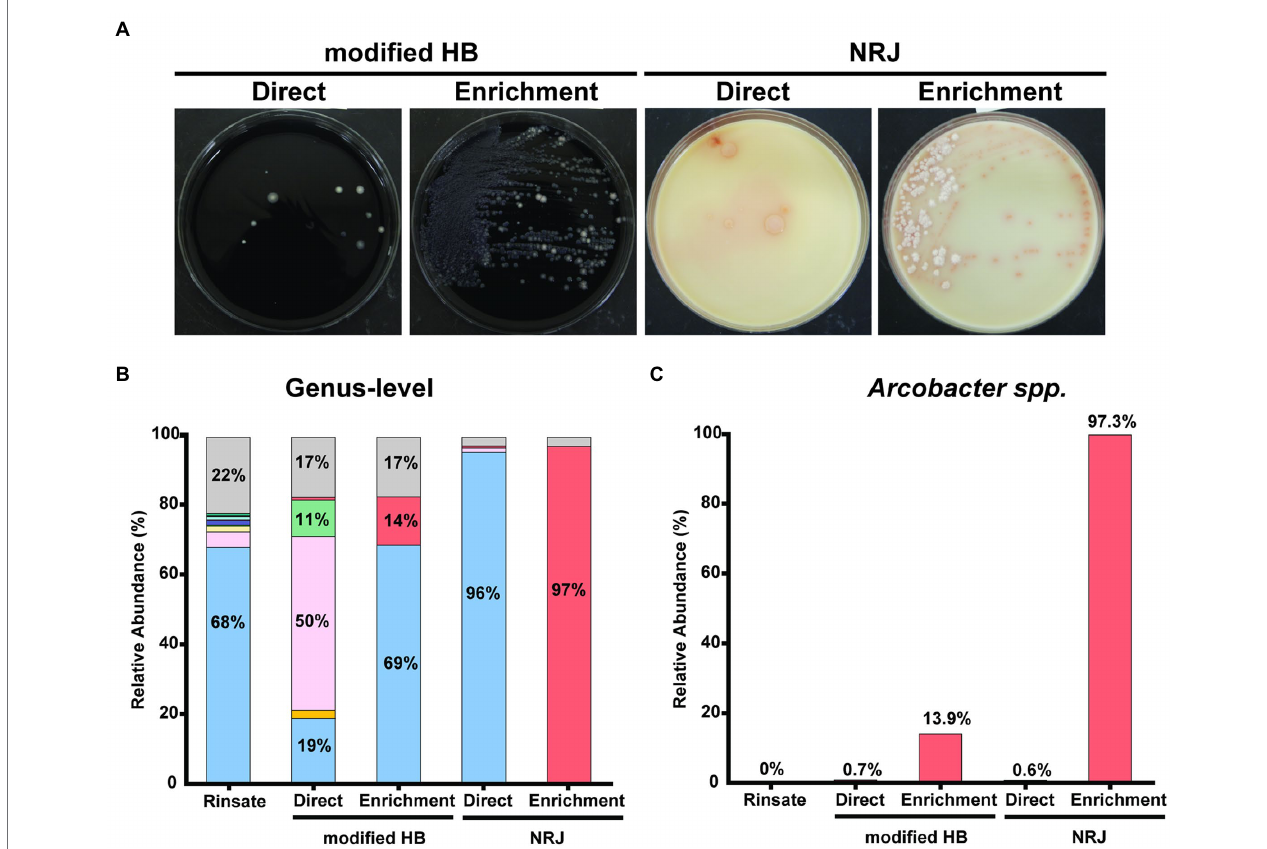
FIGURE 1 | (A) Bacterial lawn isolated in modified HB and NRJ plating media after direct and enrichment plating procedures. All colonies using modified HB appear as 1–2 mm in diameter, white-gray, convex colonies contrasting on the black charcoal agar background for both plating procedures. Direct plating on NRJ recovered 2–3 mm, beige, circular colonies with a pinkish ring. Enrichment plating on NRJ recovered two distinct morphological colonies: 2–3 mm in diameter, white, filamentous colonies and 1–2 mm in diameter, salmon-colored colonies. (B) Relative abundance of predominant (>1.0%) bacterial genera with 90% query coverage found in pooled chicken rinsate samples ( n = 30) and corresponding isolated bacterial lawns recovered from modified HB and NRJ using direct and enrichment plating methods. Represented genera are color coded: Pseudomonas (blue), Carnobacterium (pink), Yersinia (yellow), Lactococcus (green), Aeromonas (indigo), Acinetobacter (salmon), Shewanella (light blue), Brochothrix (brown), Psychrobacter (purple), Vagococcus (turquoise), Arcobacter (red), and other taxa (gray). Percentages are shown as text inside bars. (C) Relative abundance of Arcobacter spp. from samples described in (B)